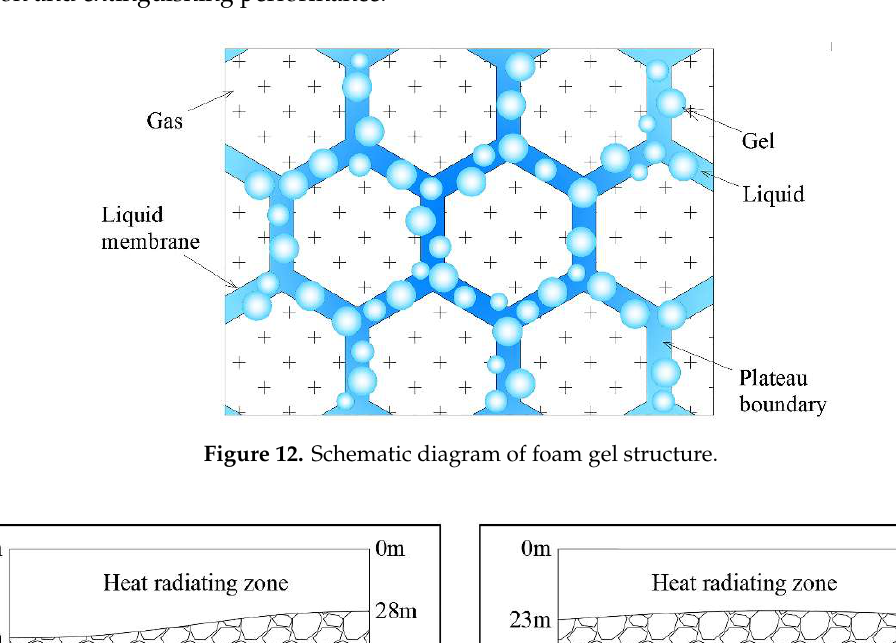
Table 3. Fire-extinguishing times of the four materials.